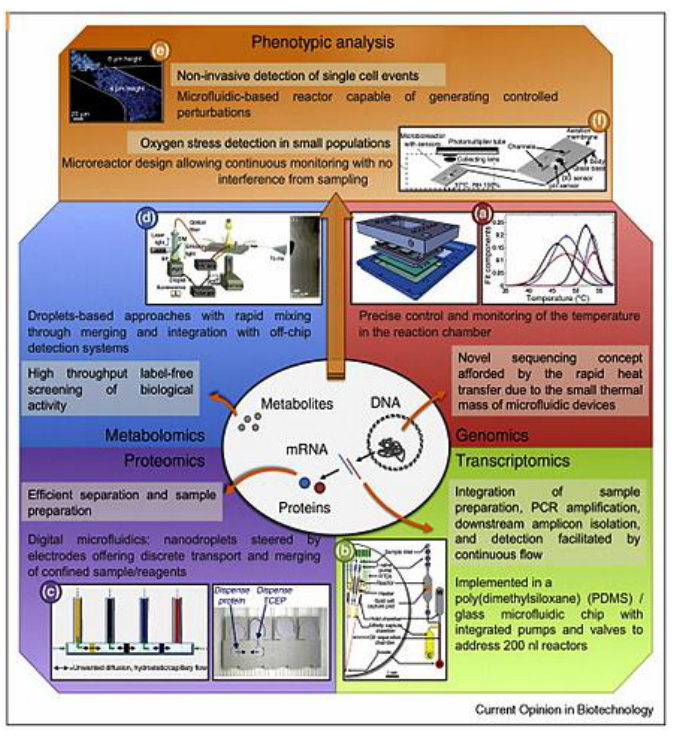
Figure 1. Different high throughput analyses carried out in microfluidic devices, highlighting the advantages of microfluidic approaches to gather information for omics. Adapted with permission from [61], Copyright (2010) Elsevier